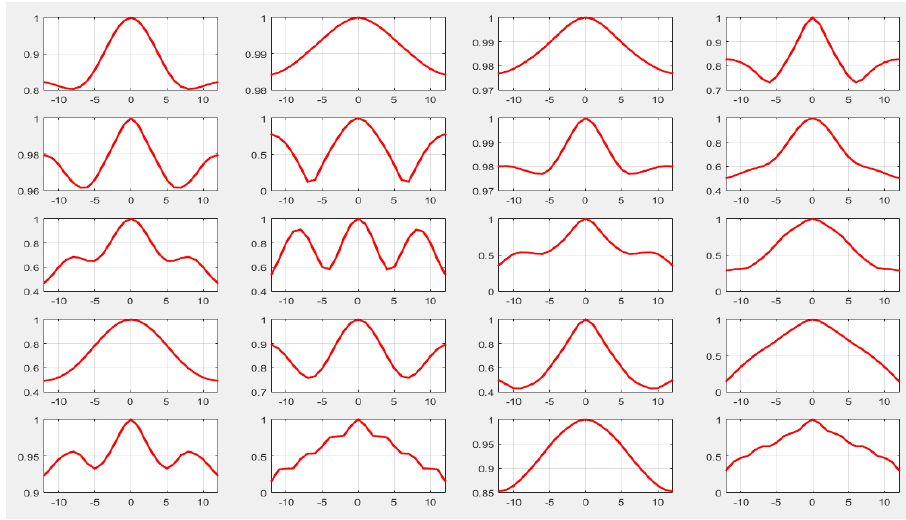
Fig. 3 CF of typical speech messages of phraseological radio